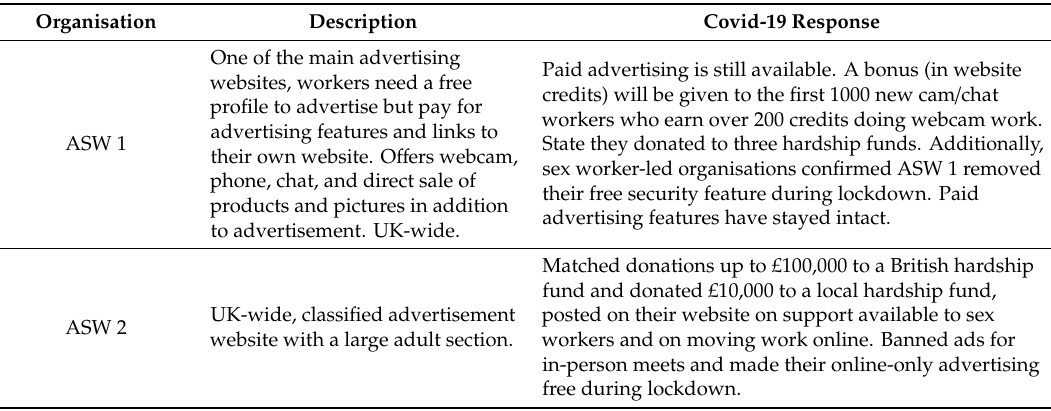
Table 1. Summary of all contacted adult service websites (ASWs) and their COVID-19